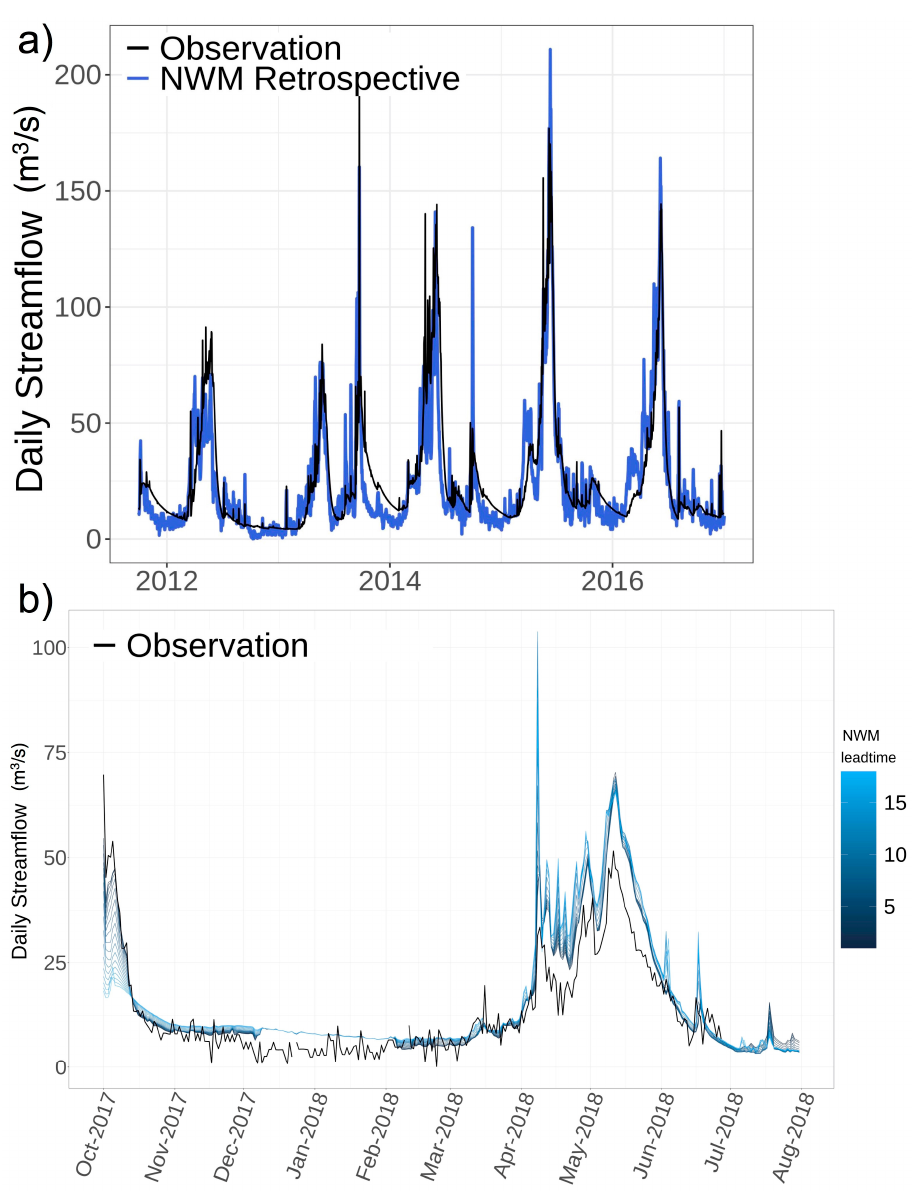
Figure 8. NWM simulated reservoir inflows into Navajo Dam: ( a ) shows the NWM retrospective simulation (v1.2 in blue) against observations (black) for a 5-year period, ( b ) shows the Navajo Dam simulated reservoir inflows for a one-year forecast period, where the blue lines are the modeled flows for all lead times and black is the BoR observations.